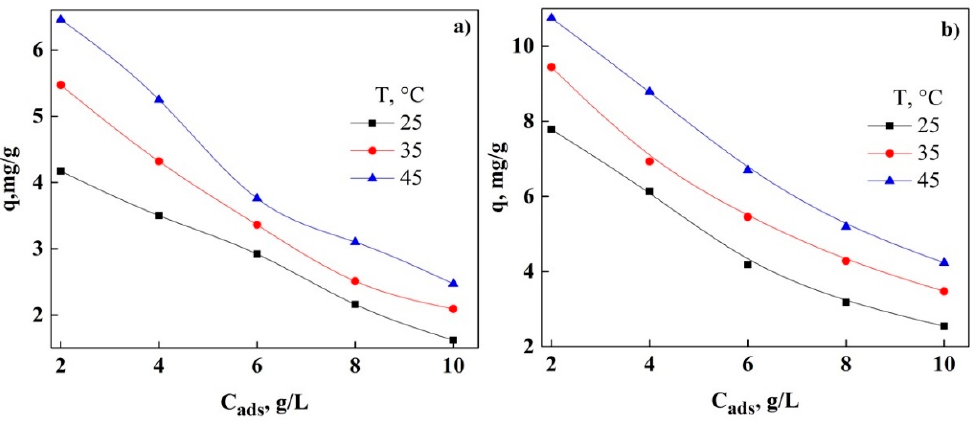
Figure 3. Effect of adsorbent concentration on DNS adsorption: ( a ) GAC and ( b ) PAC.